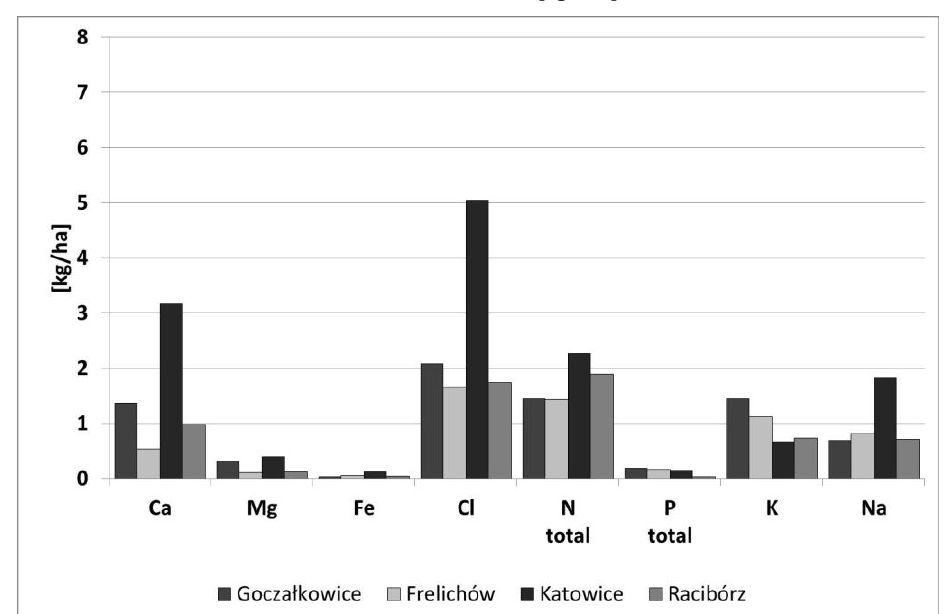
Fig. 8. Mean values of wet deposition in the winter season for: Goczałkowice, Frelichów, Katowice and Racibórz between 2011-2012 [kg·ha -1